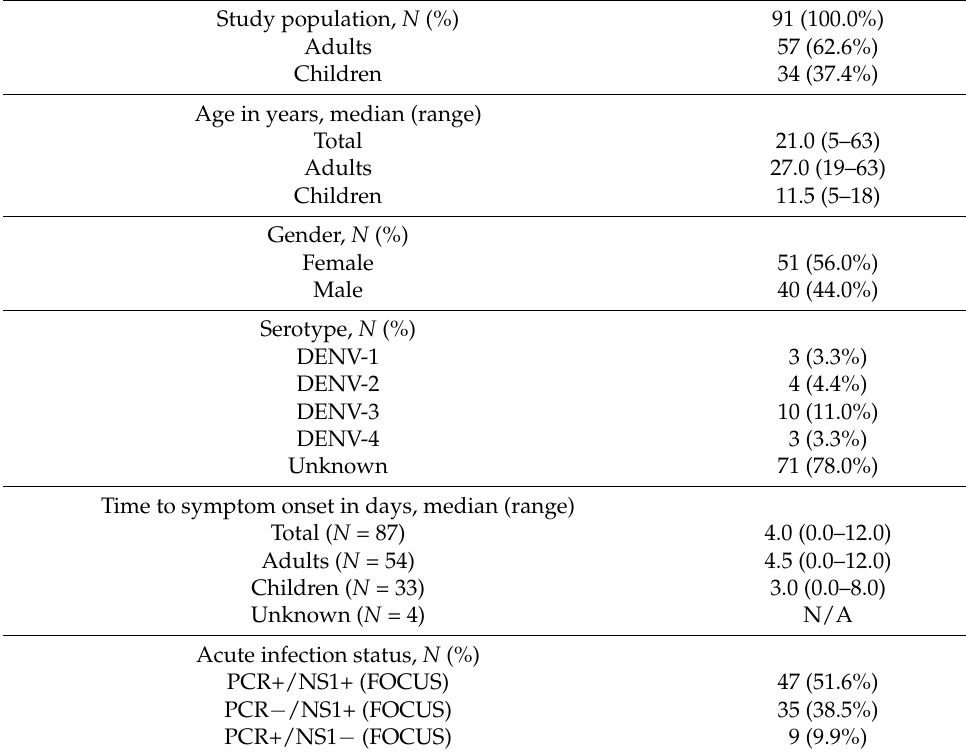
Table 1. Patients’